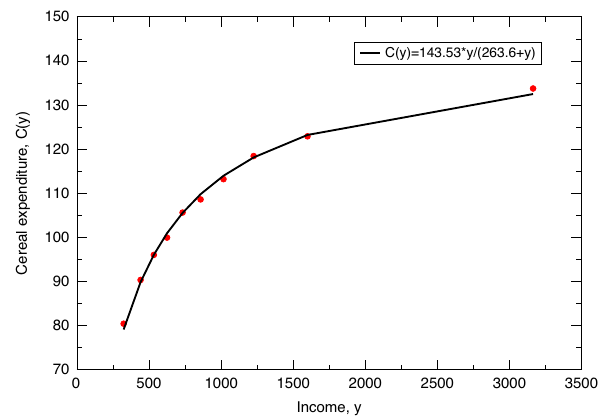
Fig. 1 Plot of expenditure C ( y ) against total rescaled income y for 2004 Indian data 26 . The dots represent actual data while the solid line is extrapolation using the formula C ( y ) = Vy /( K + y ), where V = 143.53, K = 263.6. This Engel curve fi ts perfectly with the data and validates the machine learned stochastic model.